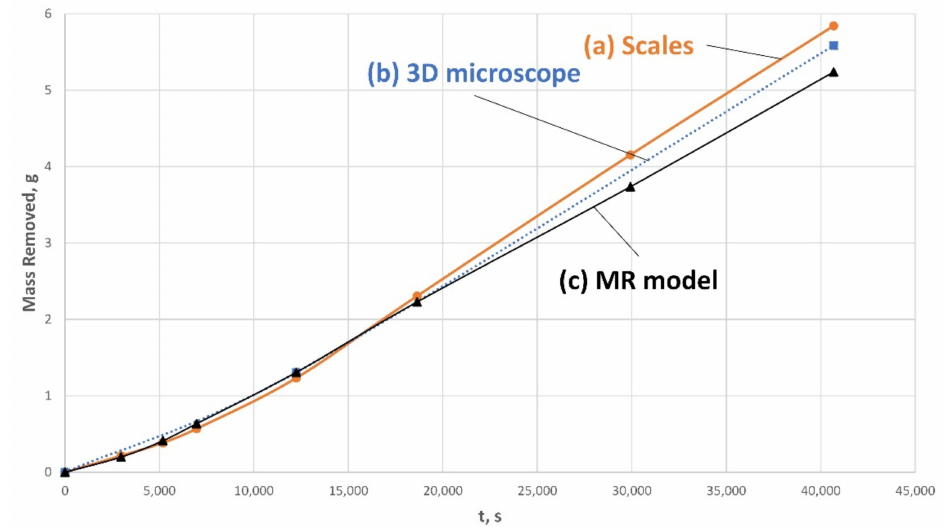
Figure 21. S-shape specimen: MR global measurements using ( a ) scales, ( b ) 3D microscope, ( c ) MR model (average